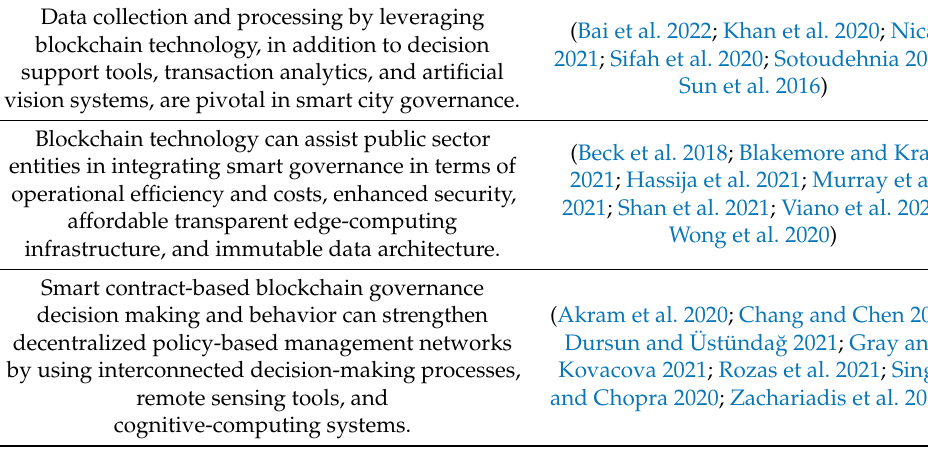
Table 4. Synopsis of evidence as regards focus topics and descriptive outcomes. Data collection and processing by leveraging blockchain technology, in addition to decision support tools, transaction analytics, and artificial vision systems, are pivotal in smart city